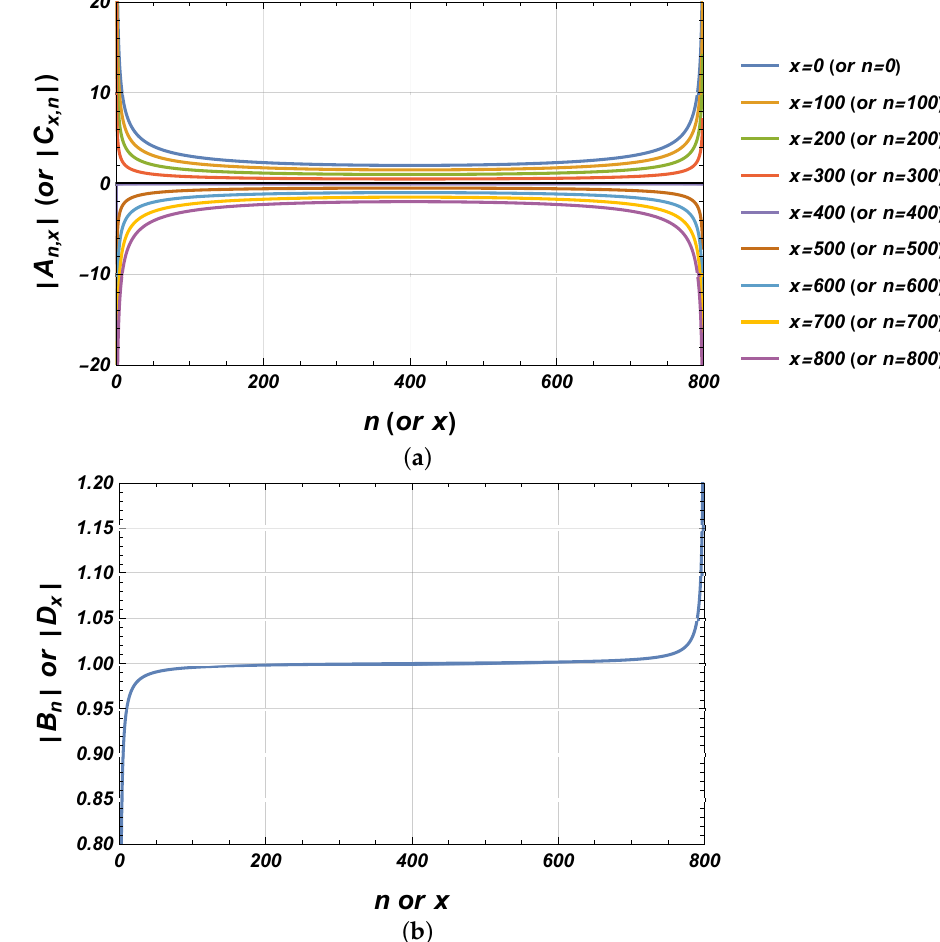
Figure 6. The plots of the KPs’ coefficients in (9) or (11): ( a ) plot of | A n , x | (or | C x , n | ) with respect to n (or x ), and ( b ) plot of | B n | (or | D x | ) with respect to n (or x ). Assuming p = 0.5 and N =